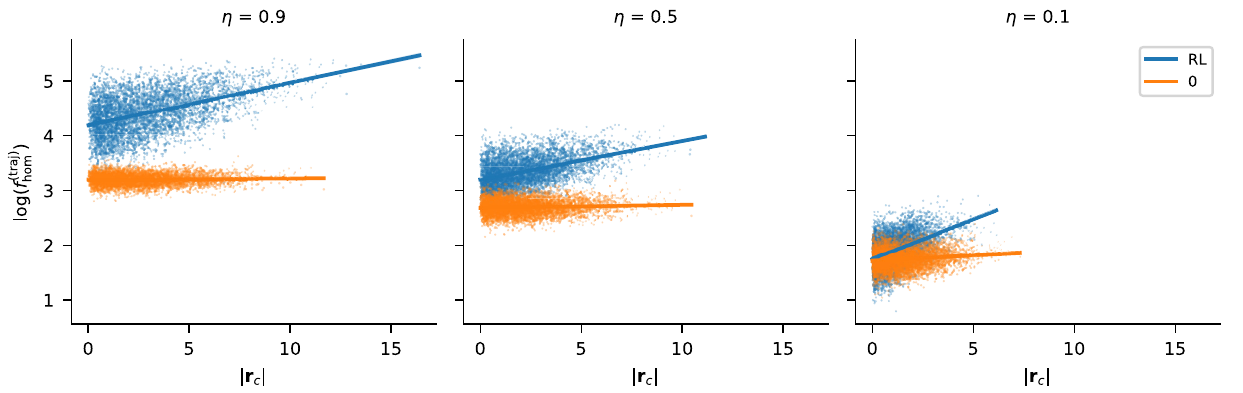
FIG. 9. Scatter plot between the absolute value of the first-moment vector |¯ r c | and the trajectory contribution to the homodyne ( traj ) Fisher information log f at time κ t = 180 and for different values of η . Only the points corresponding to the agent strategy and the hom ( traj ) = 0 for the OL control strategy. no-control strategy are plotted, as f hom